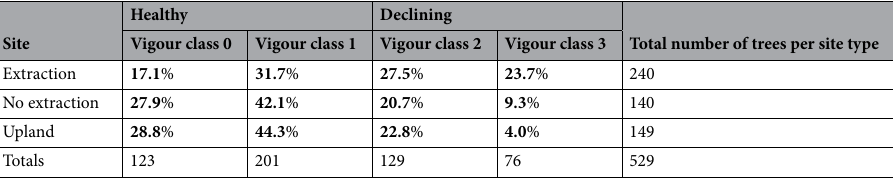
Table 1. Percentages and total number of sampled trees per vigour class at each